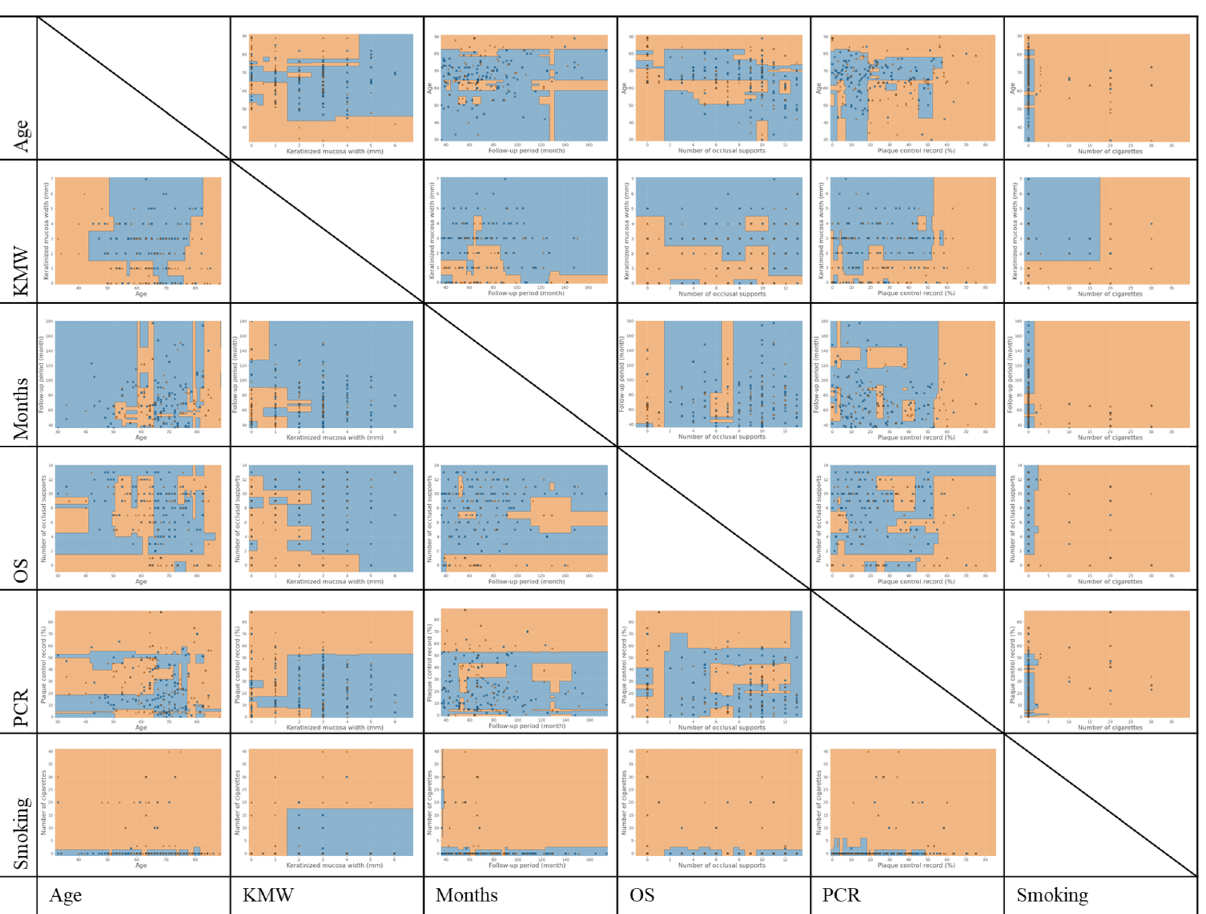
Figure 4. Classification diagrams for predicting onset of peri-implantitis with RF. Testing data that fall in orange areas are predicted to be peri-implantitis and those that fall in blue areas are predicted to be non- peri-implantitis. PCR: plaque control record, OS: number of occlusal supports, KMW: keratinized mucosa width. This figure was created with Python version 3.7.7 (Python Software Foundation, Beaverton, OR) and PowerPoint 2019 version 1808 (Microsoft, Inc, Redmond,